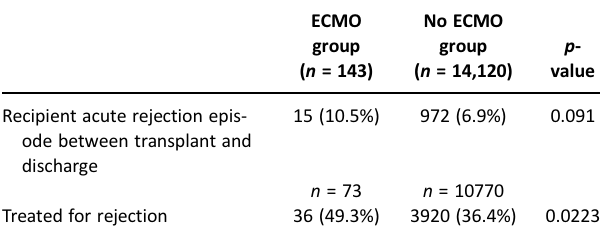
Table 8. Rejection episodes.